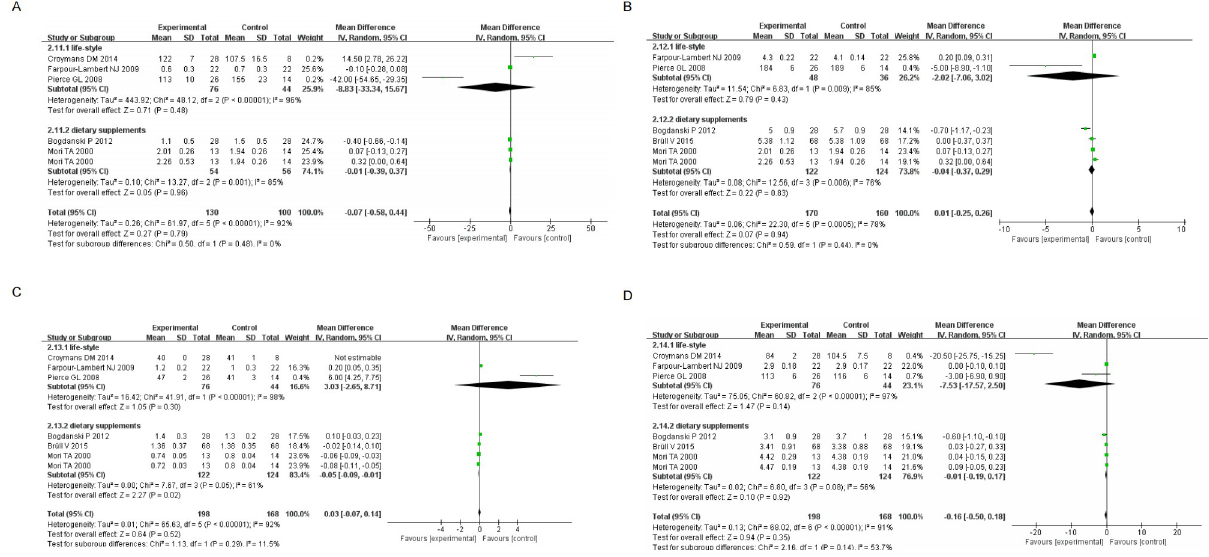
Fig 6. Forest map secondary outcome indicators (A) TG Forest map secondary outcome indicators (B) TC Forest map secondary outcome indicators (C) HDL Forest map secondary outcome indicators (D) LDL Forest map secondary outcome indicators.